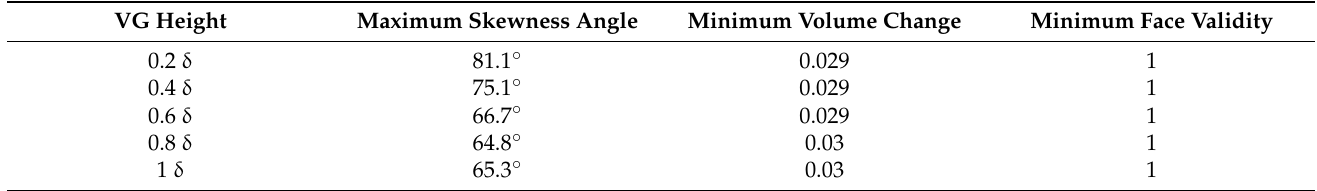
Table 2. Cell quality parameters of the used meshes with the fully resolved mesh model.